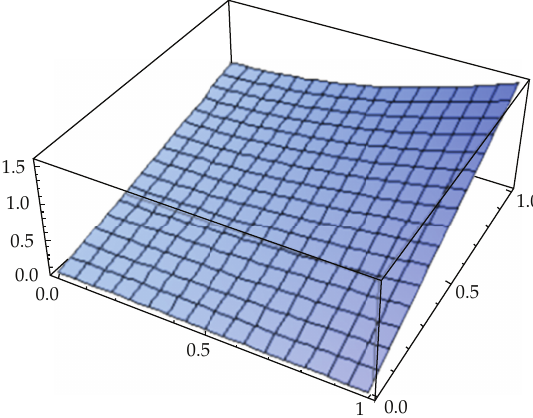
Figure 2: z -component u z (cid:3) r,θ,z (cid:4) (cid:5) (cid:3) − 1 /r (cid:4)(cid:3) ∂ψ/∂r (cid:4) of the velocity profile given by OHAM, when R (cid:5) 1 ,γ (cid:5)